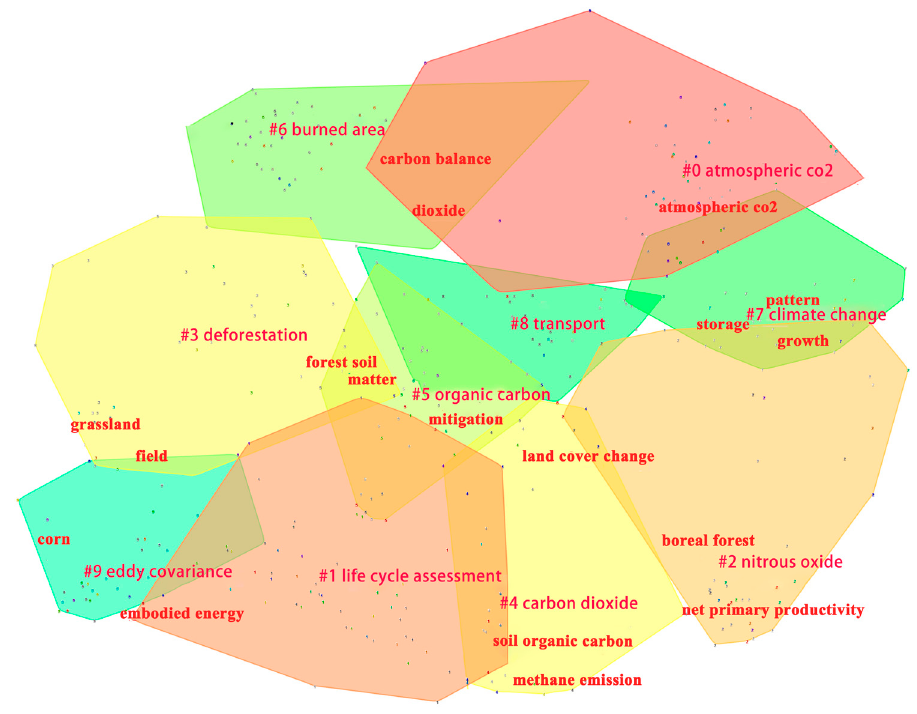
Figure 9. Cluster map of keywords for carbon emissions research in the WoS database.